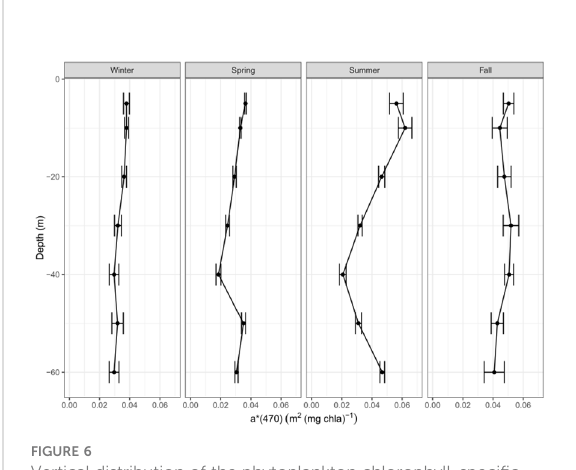
FIGURE 6 Vertical distribution of the phytoplankton chlorophyll-speci fi c